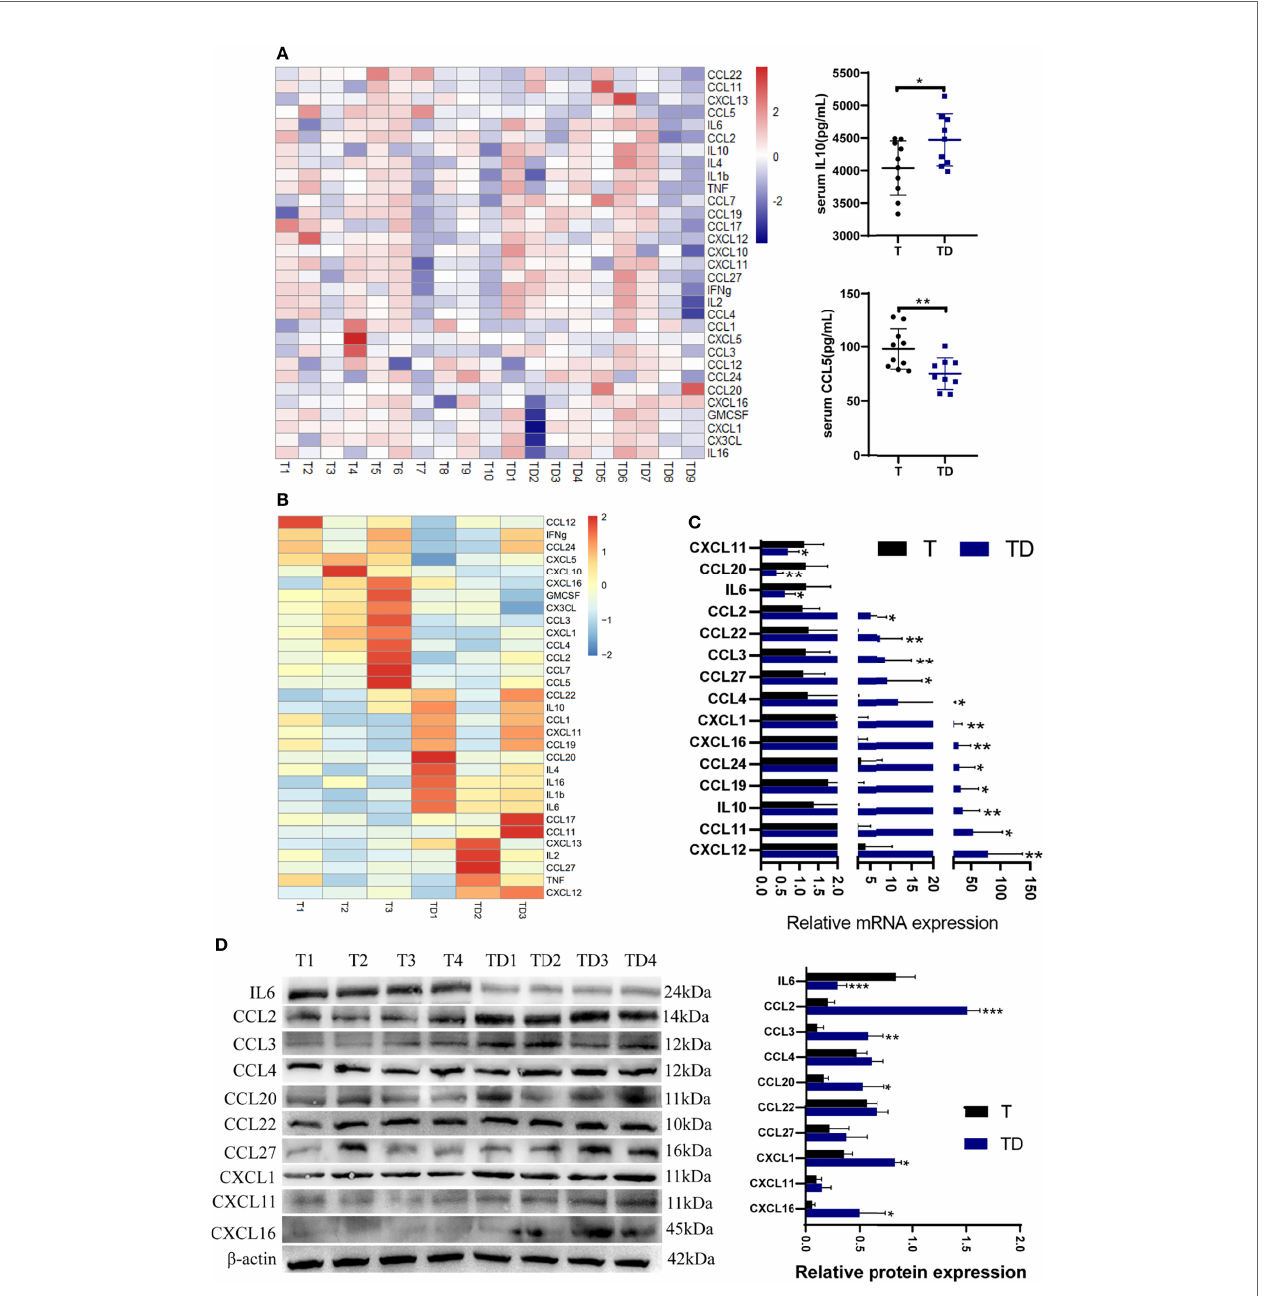
FIGURE 6 | Chemokine differences between tumor-bearing mice with and without damp-heat syndrome. (A) Heatmap indicating serum chemokine distribution between the two groups (n = 10 in the T group, n = 9 in the TD group). (B) Heatmap indicating tumor tissue chemokine distribution between the two groups (n = 3 in each group). (C) Relative mRNA expression of tissue chemokines tested by qPCR (n = 10 in the T group, n = 9 in the TD group). (D) Relative protein expression of tissue chemokines tested by western blotting (n = 8 in each group). *p < 0.05, **p < 0.01, ***p < 0.001 compared with the T